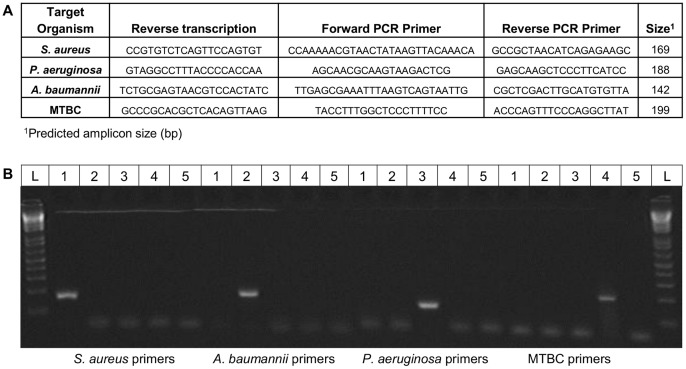
Reverse transcription and PCR primers.A: Oligonucleotides used for priming reverse transcription of pre-rRNA (cDNA synthesis), and forward and reverse PCR primers for amplifying cDNA. B: Specificity of PCR primer sets designed for S. aureus, A. baumannii, P. aeruginosa, and MTBC. Each primer set was used in endpoint PCR conducted on purified DNA from all the four organisms. Key: L, 1 Kb+ DNA ladder; 1, S. aureus DNA; 2, A. baumannii DNA; 3, P. aeruginosa DNA; 4, M. tuberculosis DNA; 5, negative control (water). Lowest three bands of ladder are 100, 200, and 300 bp. A repeat experiment yielded identical results.